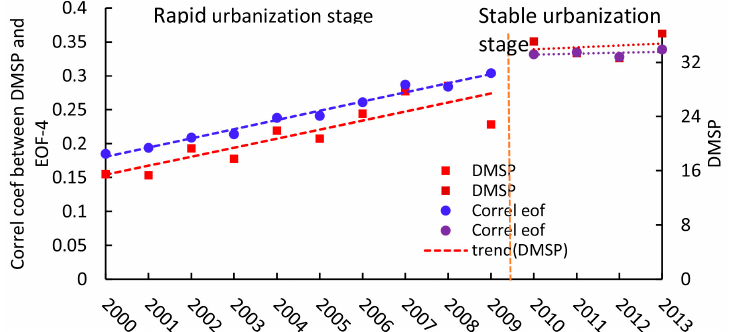
Figure 8. Trend of the correlation coefficient between precipitation spatial distribution of EOF-4 and DMSP from 2000 to 2013 at 0.1° × 0.1° grid scale.